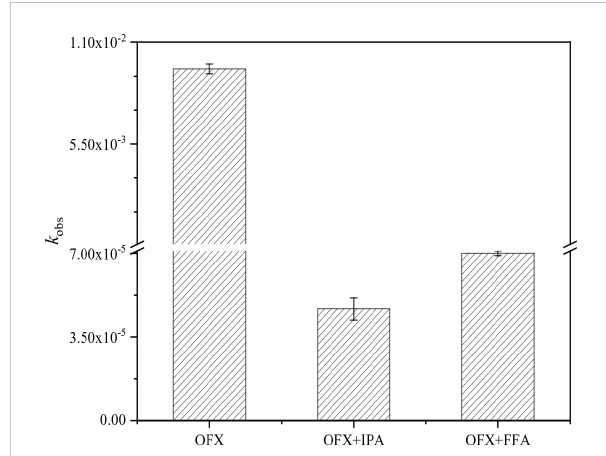
FIGURE 1 Observed photodegradation rate of OFX. The data were presented as mean; error bars denote standard deviations (p< 0.05, n = 3). OFX, o fl